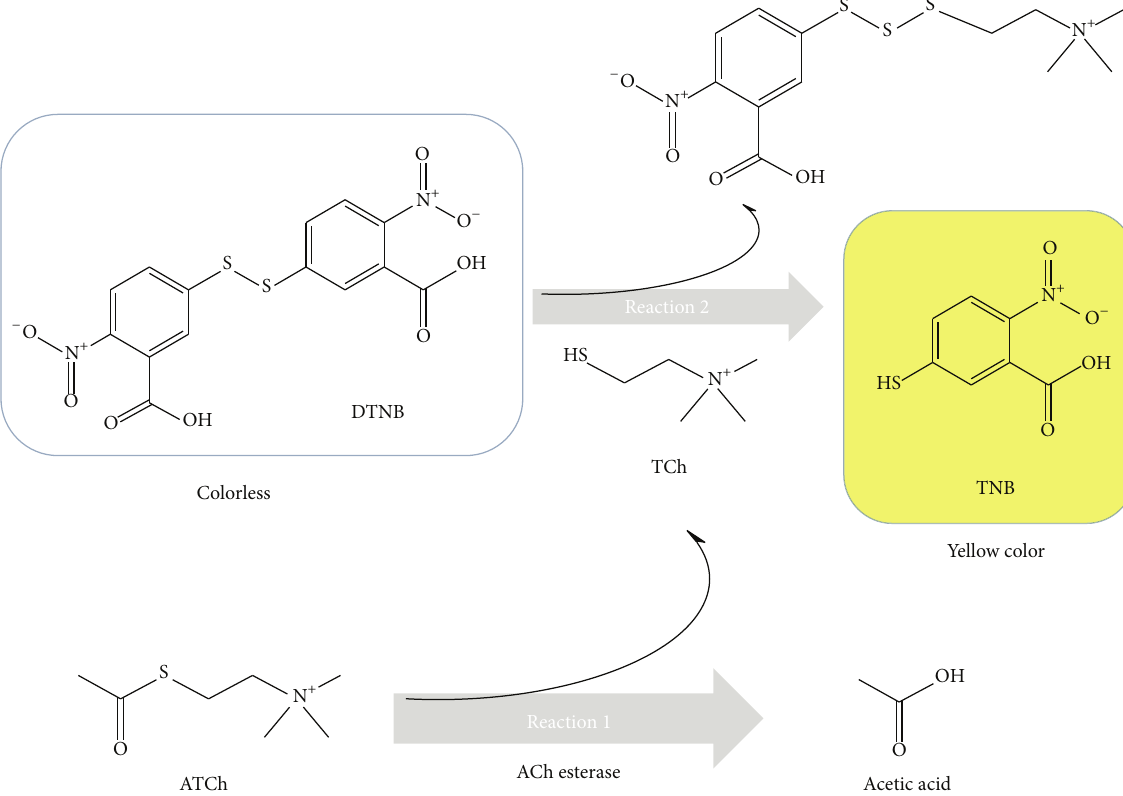
Figure 2: Two-step sequential reactions of acetylthiocholine (ATCh) for production of yellow colored TNB. In reaction 1, ATCh is broken to acetic acid and thiocholine (TCH). The free sulfhydryl group of TCh is quantified through Ellman’s method in reaction 2. The resulting TNB is used in a direct determination of the activity of ACh